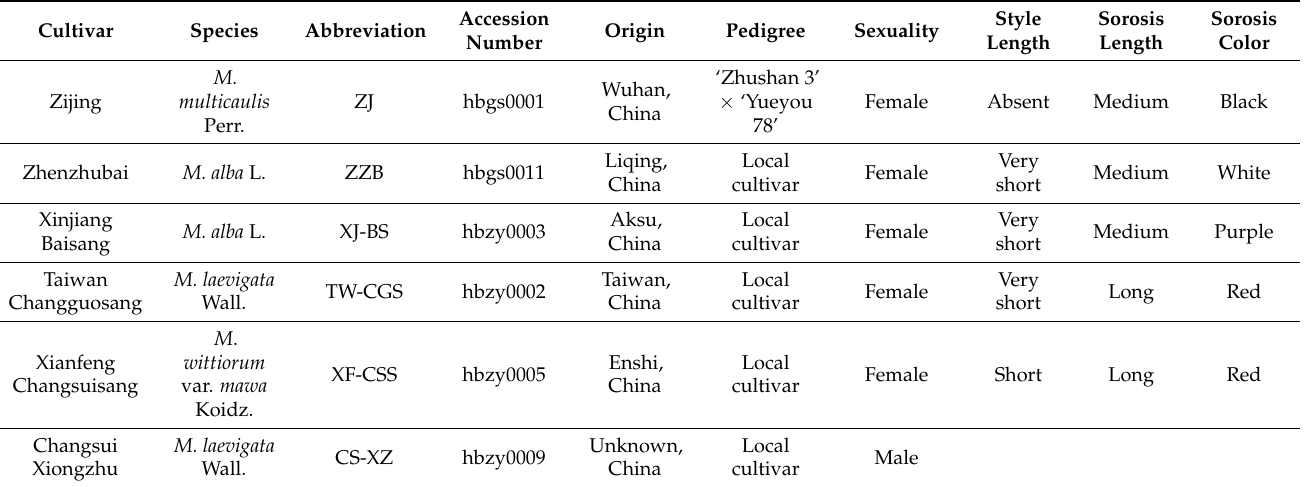
Table 1. Names, species, abbreviations, origin, pedigree and some agronomic traits of the mulberry cultivars examined in this